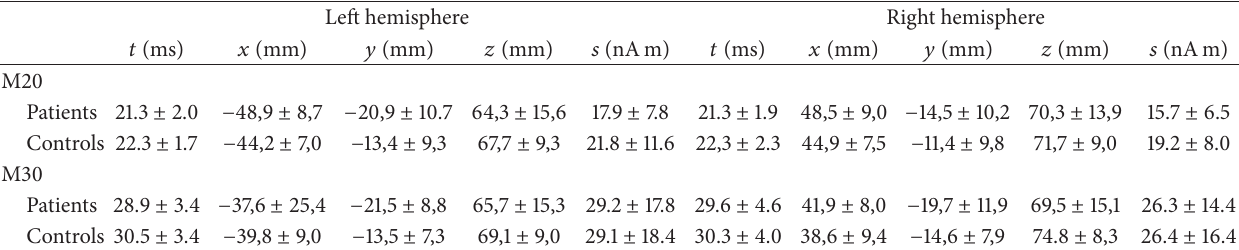
Table 1: M20 and M30 ECD characteristics in patients and controls.